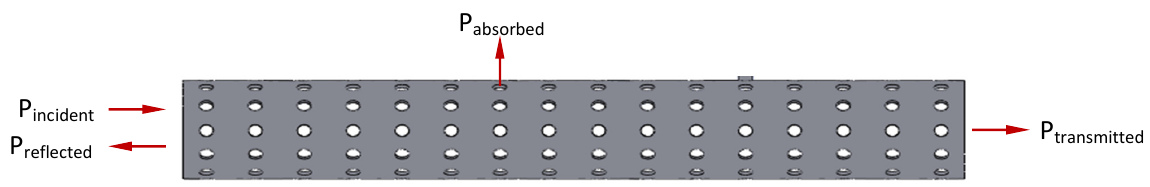
), (P ), (P ), and transmitted absorbed reflected